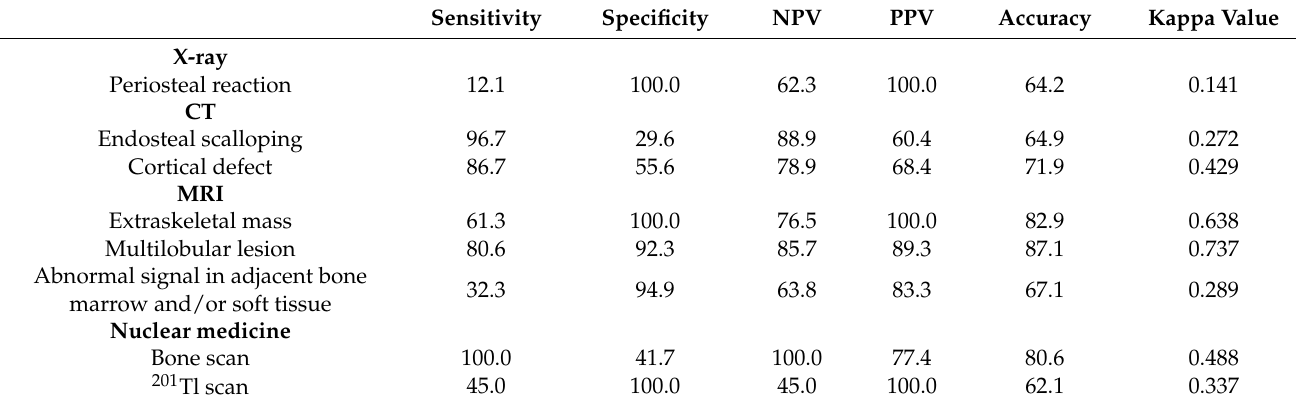
Table 3. The predictive powers of each radiological findings compared with histological diagnoses.